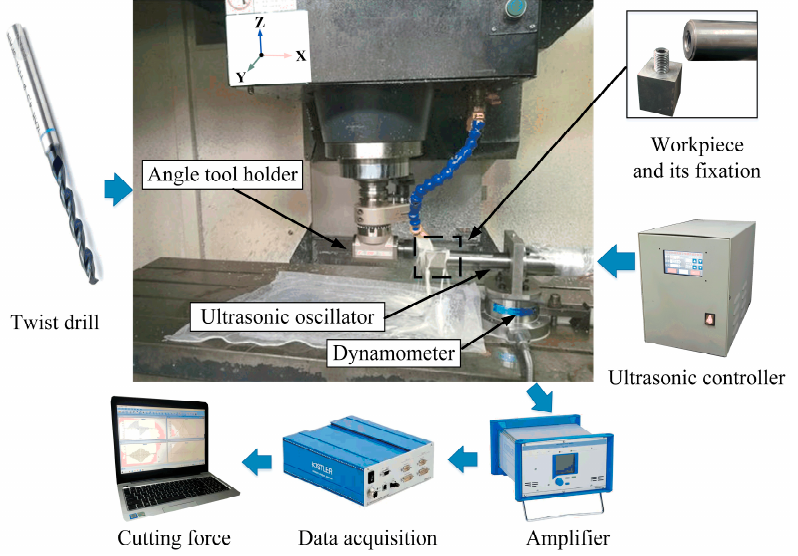
Figure 2. Experimental setup.